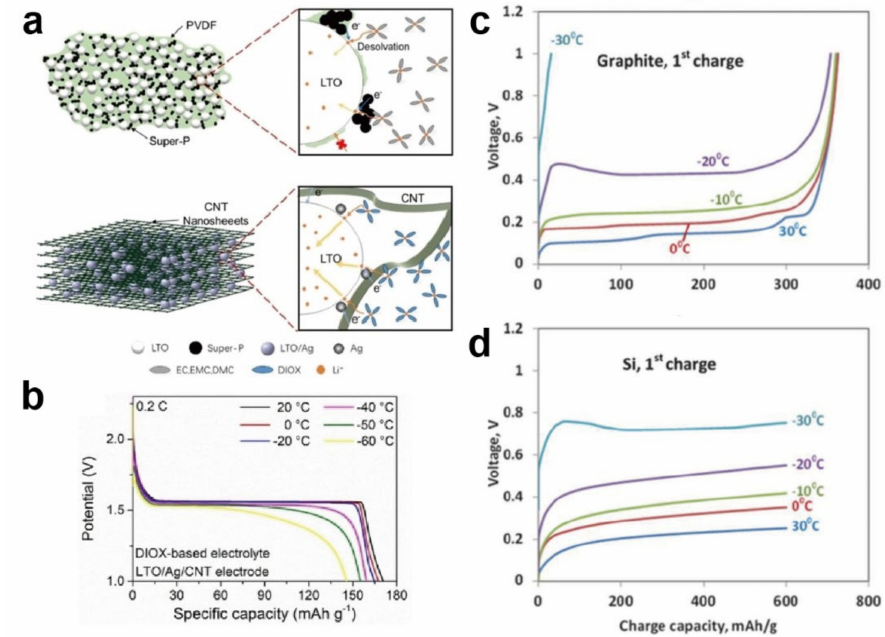
Figure 5. ( a ) Schematic illustration of common LTO with conductive agent (Super − P), polymer binder (PVDF), and schematic illustration of binder-free LTO/Ag/CNT, showing their enlarged local parts during lithiation on the right; ( b ) charge voltage profiles under different temperatures at 0.2 C of LTO/Ag/CNT electrode [81]. Reproduced with permission from ChemElectroChem; published by Wiley-VCH Verlag GmbH & Co. KGaA, 2020; ( c , d ) the first charge curves at 0.25 C and different temperatures of silicon anode and graphite anode [82]. Reproduced with permission from Journal of the Electrochemical Society; published by IOP Publishing Ltd.,